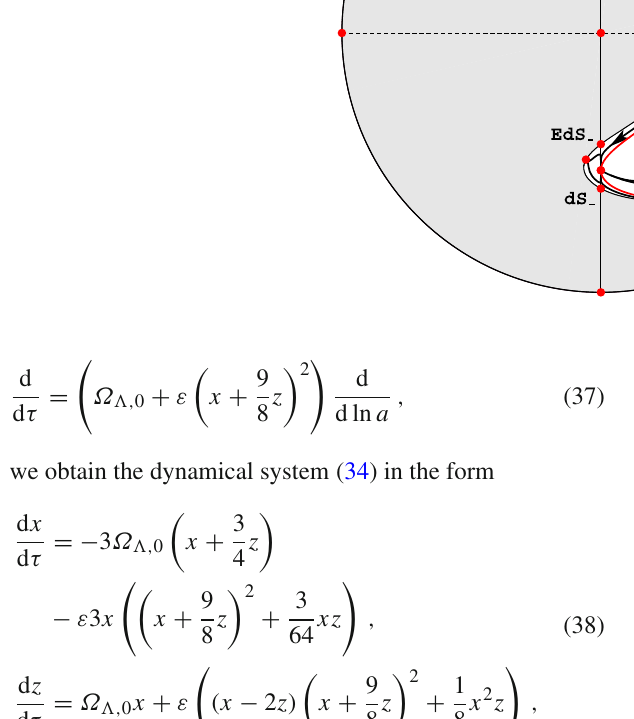
Fig. 4 The phase space diagrams representing evolutional paths of the decoupled part in the ( u , ¯ v) dynamical variables of the system (22) with λ = − 20 for the canonical ε = + 1 (top) and the phantom ε = − 1 (bottom) scalar fields. The shaded regions of the phase space are unphysical where the energy conservation condition (21) is negative. Direction of arrows on the phase space trajectories indicates expansion of the universe. For λ < − 5 both states the Einstein–de Sitter EdS − and the de Sitter dS − are in the form of saddle type critical points. Note existence of the de Sitter state dS + for the canonical scalar field ε = + 1 which is asymptotically stable for negative potential functions